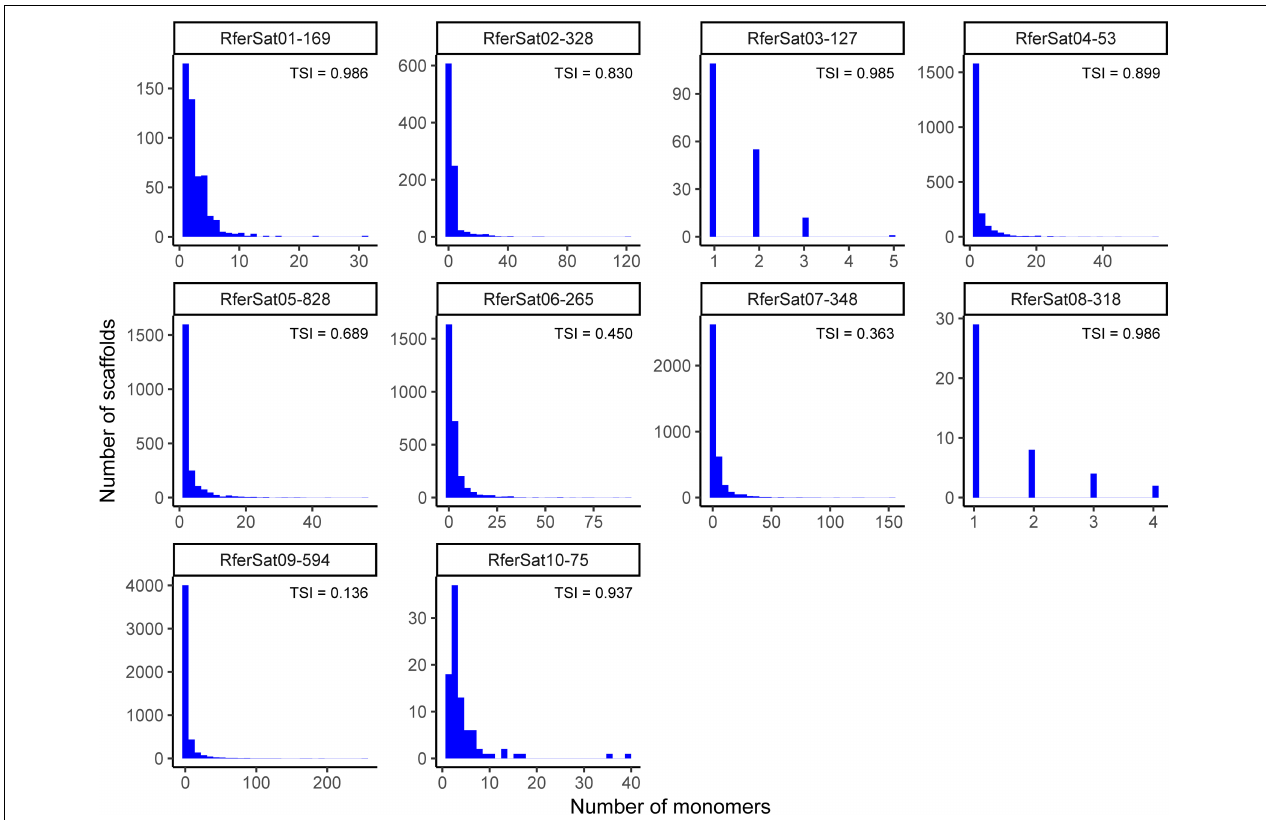
FIGURE 4 | Monomers distribution of most abundant satDNA families in Rhynchophorus ferrugineus assembled genome. Histograms relate number of scaffolds and